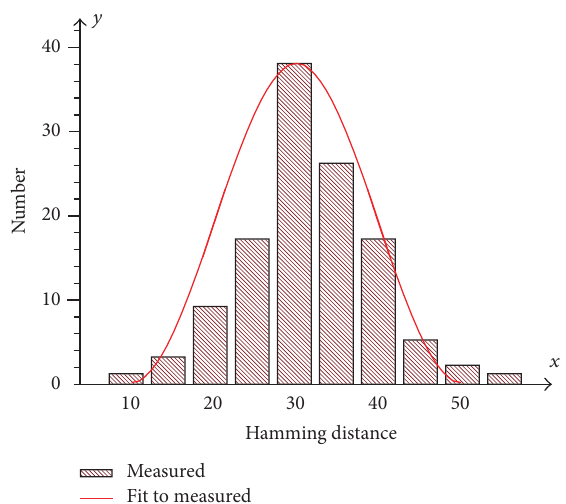
Figure 12: Measured hamming distance for IM-PUF.